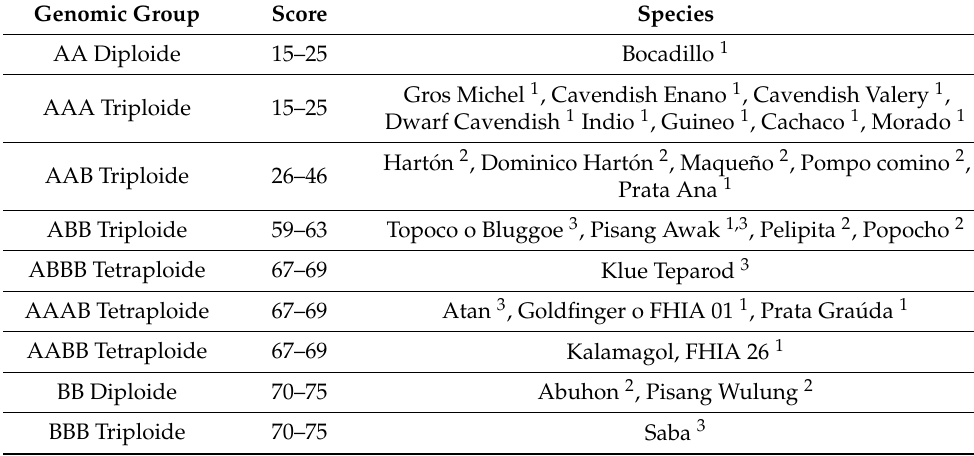
Table 1. Classification of bananas and